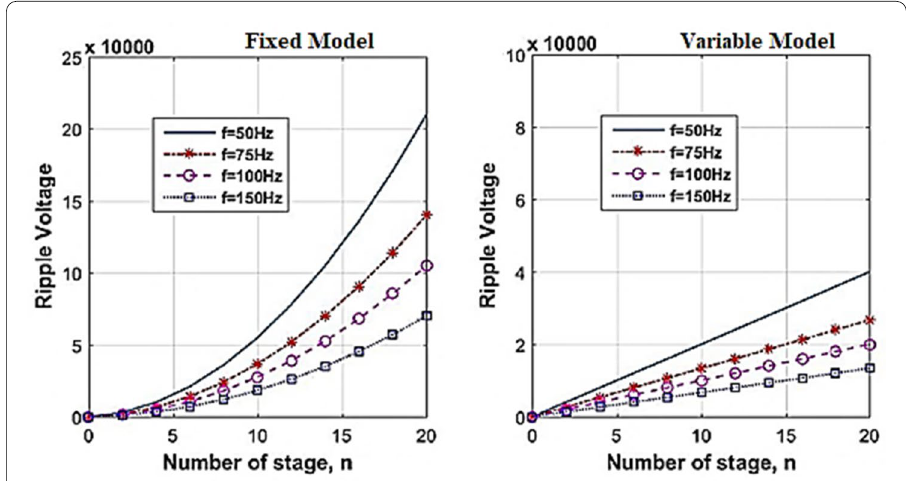
Fig. 4 Ripple Voltage in CWVM against different